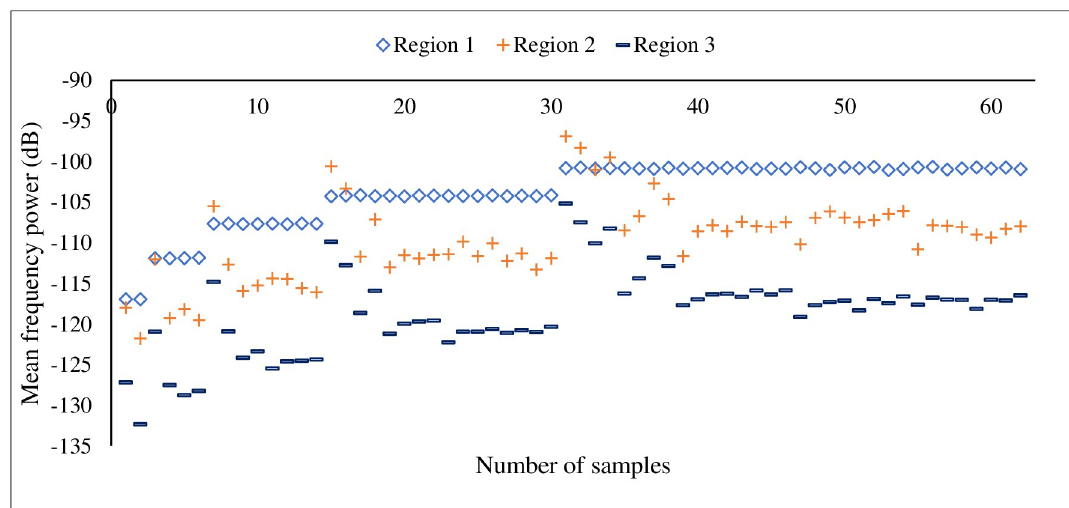
Fig 14. Mean frequency power, frequency-domain features for three stages of corrosion.